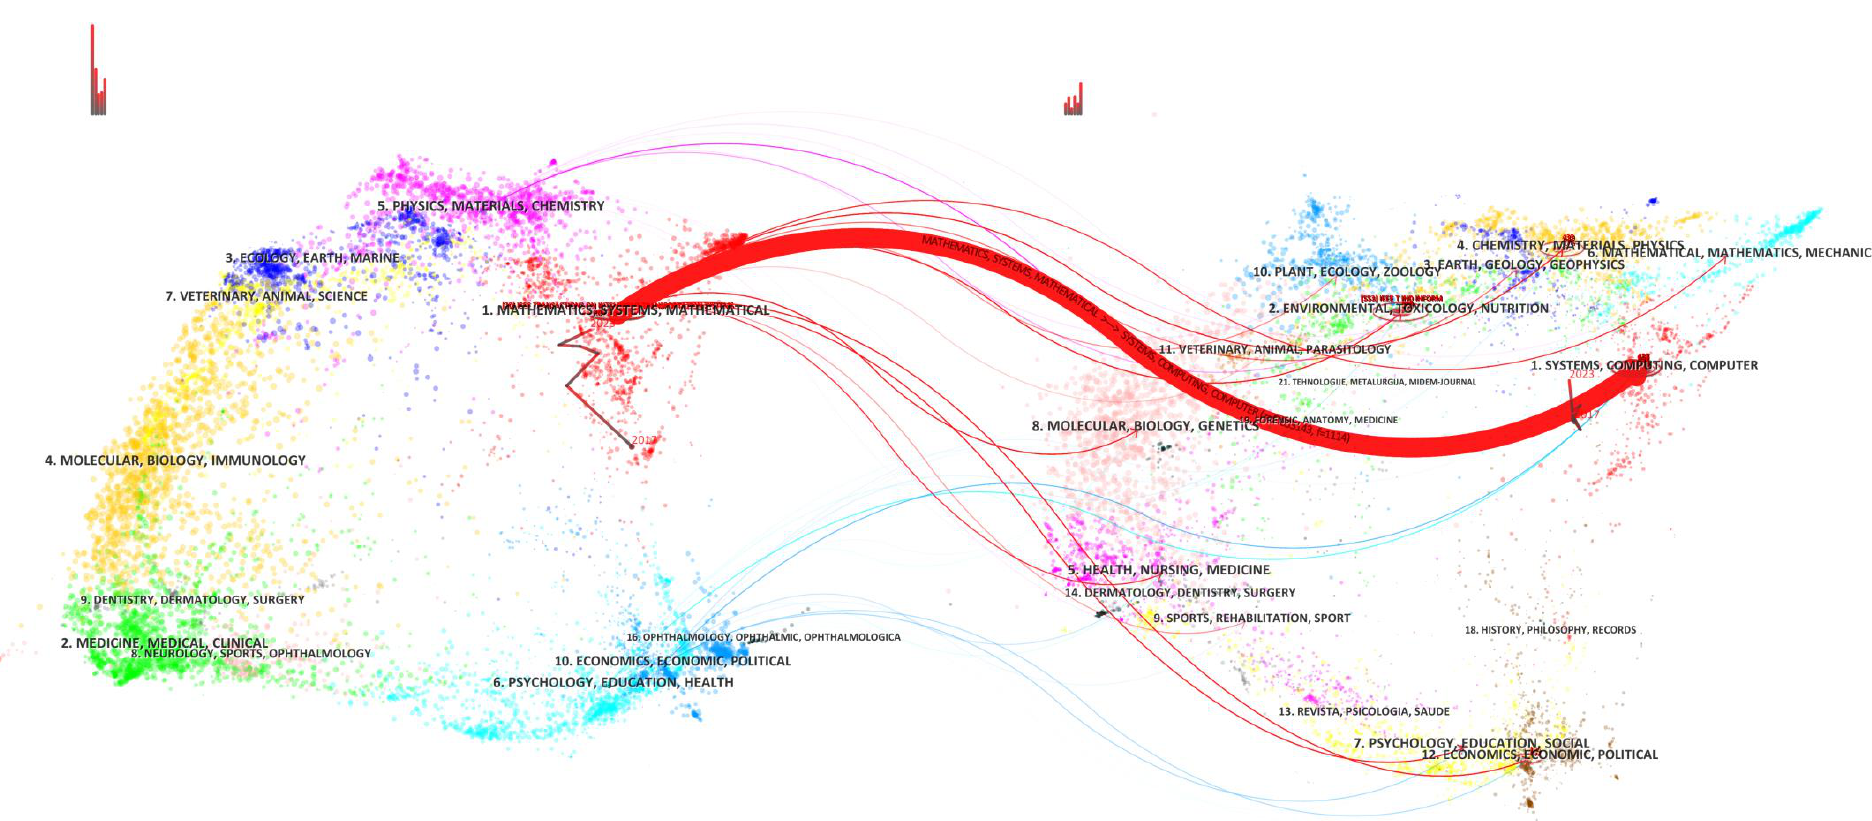
Figure 16. Domain-level citation pattern in the subject field.